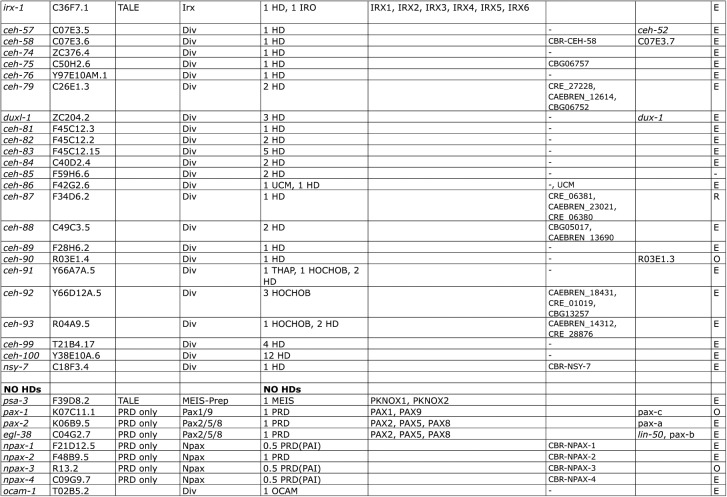
Second part of Fig 2.